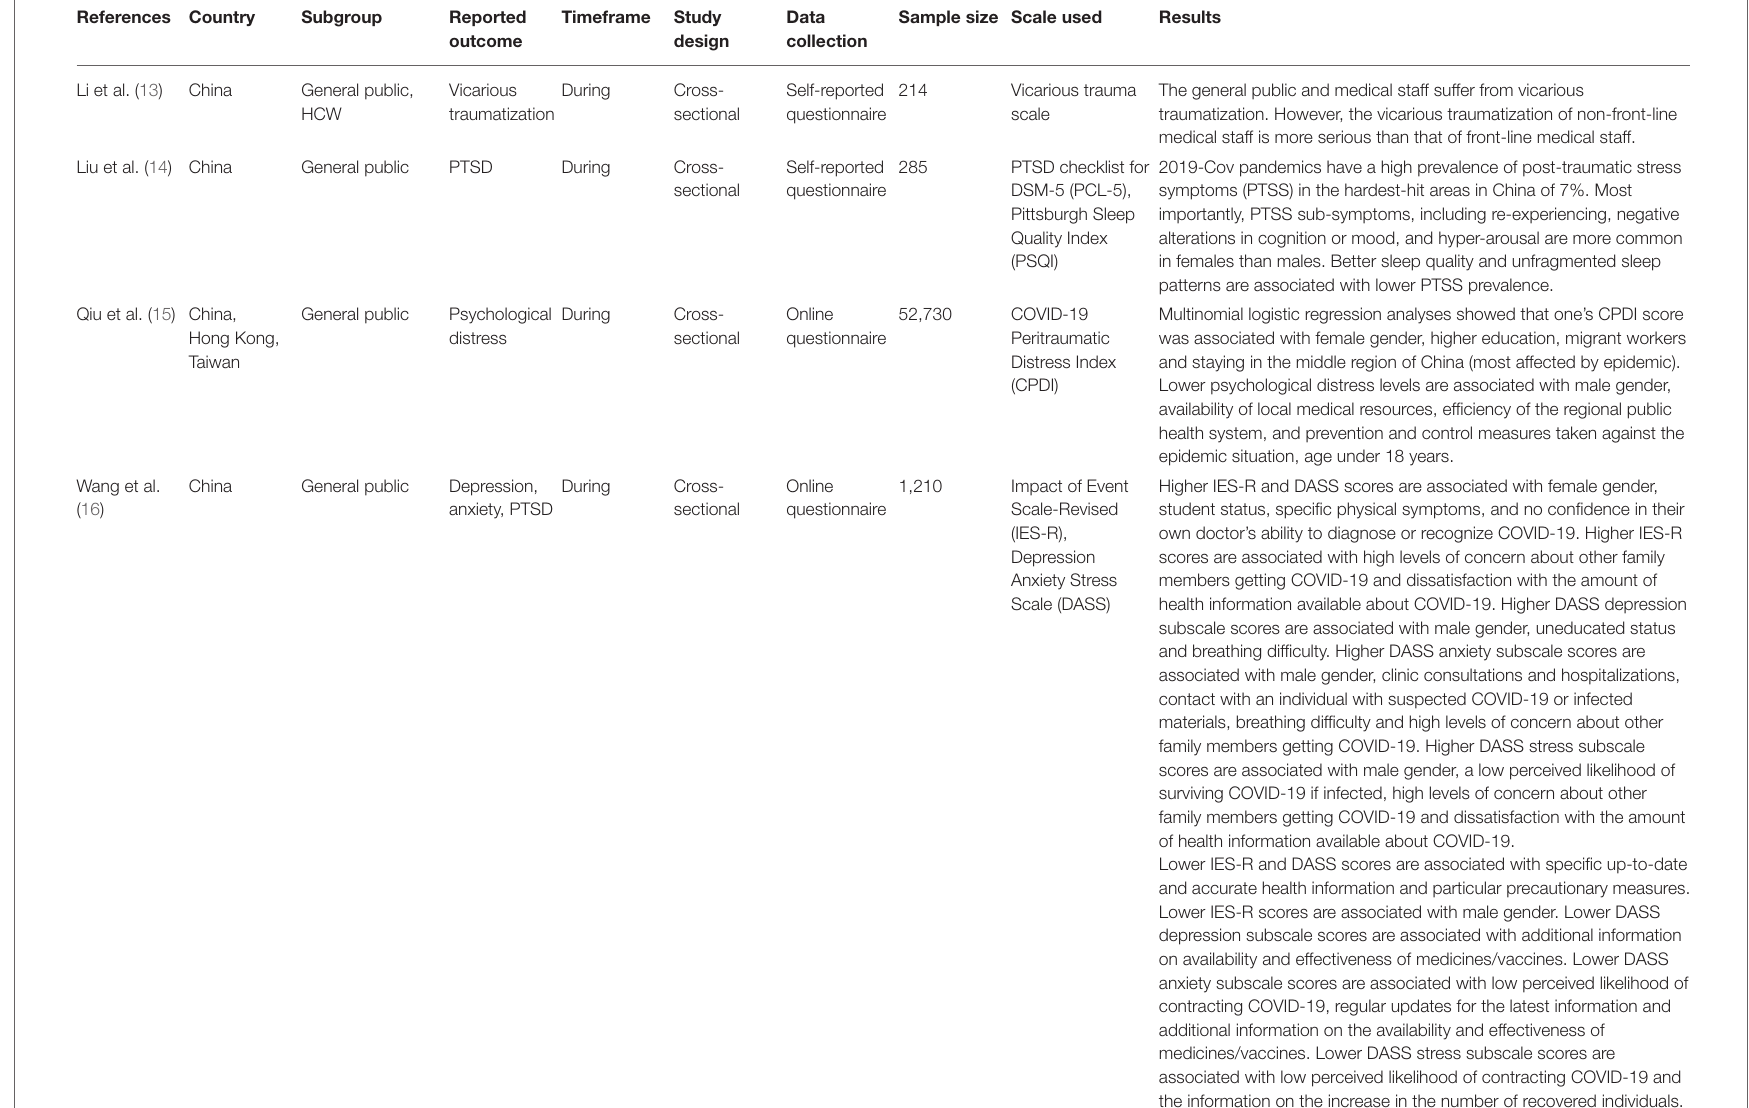
TABLE 2 | Summary of the study characteristics for COVID-19 articles. References